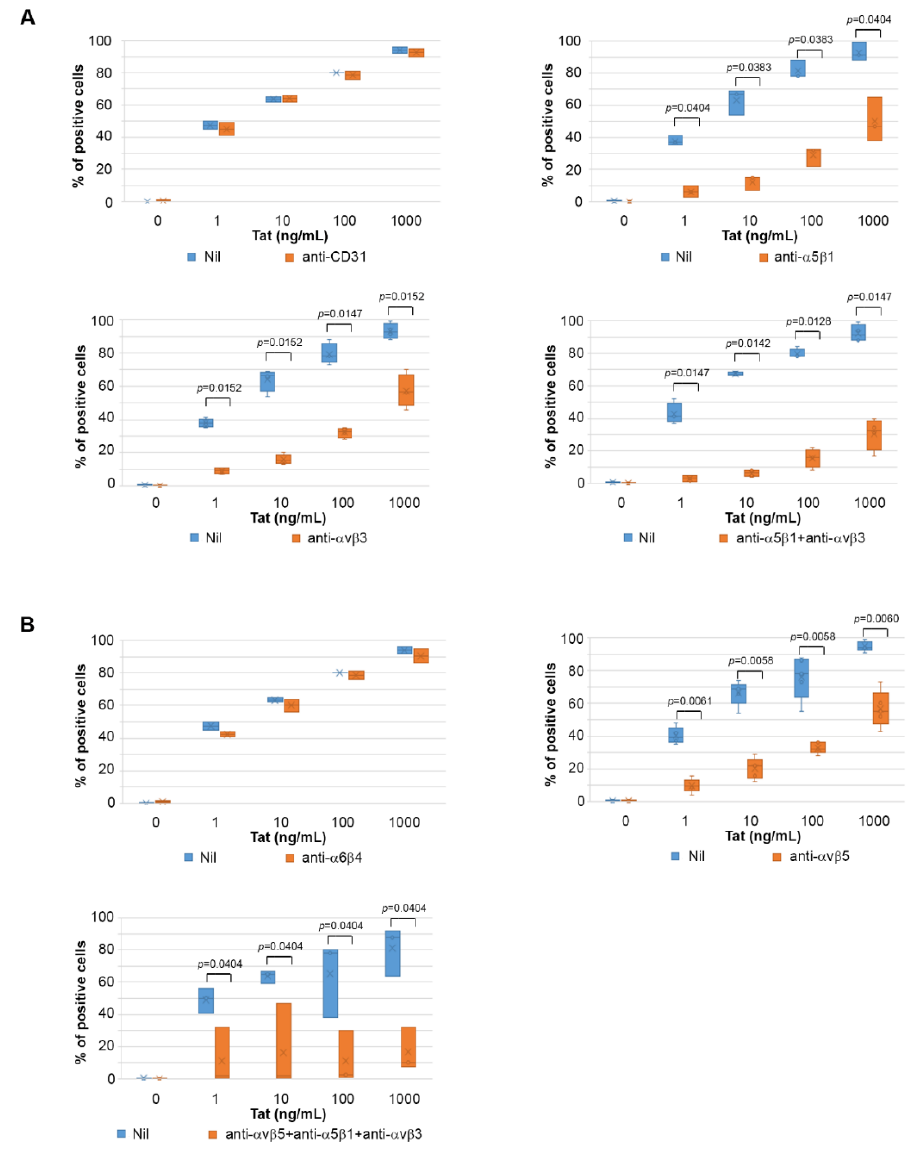
Figure 4. Blockade of Tat entry in IC-HUVEC by antibodies directed against the α5β1, αvβ3, and/or αvβ5 integrin. In ( A ), activated HUVEC were suspended and then incubated for 2 h with 5 μg/mL of monoclonal antibodies (mAb) directed against CD31 (upper left panel), α5β1 (upper right panel), or αvβ3 (lower left panel), or with anti-α5β1 and anti-αvβ3 mAb, combined together at 5 μg/mL each (lower right panel). In ( B ), IC-HUVEC were suspended and then incubated for 2 h with 5 μg/mL of anti-α6β4 mAb (upper left panel), or with 5 μg/mL of anti-αvβ5 mAb, alone (upper right panel) or combined with anti-α5β1 and anti-αvβ3 mAb (lower panel). For both A) and B), IC-HUVEC incubated with Ab dilution buffer (PBS-0.1% BSA) were employed as controls (Nil). After incubation, IC-HUVEC was exposed for 10 min to biologically active Tat (1–1000 ng/mL) or its buffer. Intracellular Tat content was assayed by intracellular staining and flow cytometry as described. Results are expressed as the percentage of positive cells as compared to isotype-stained samples and non-permeabilized cells. Box-plot data obtained from three to four independent experiments and analyzed by the Mann–Whitney test are shown. Dots indicate individual measures. Orange plots refer to IC-HUVEC incubated with the said mAbs; blue plots refer to control IC-HUVEC.